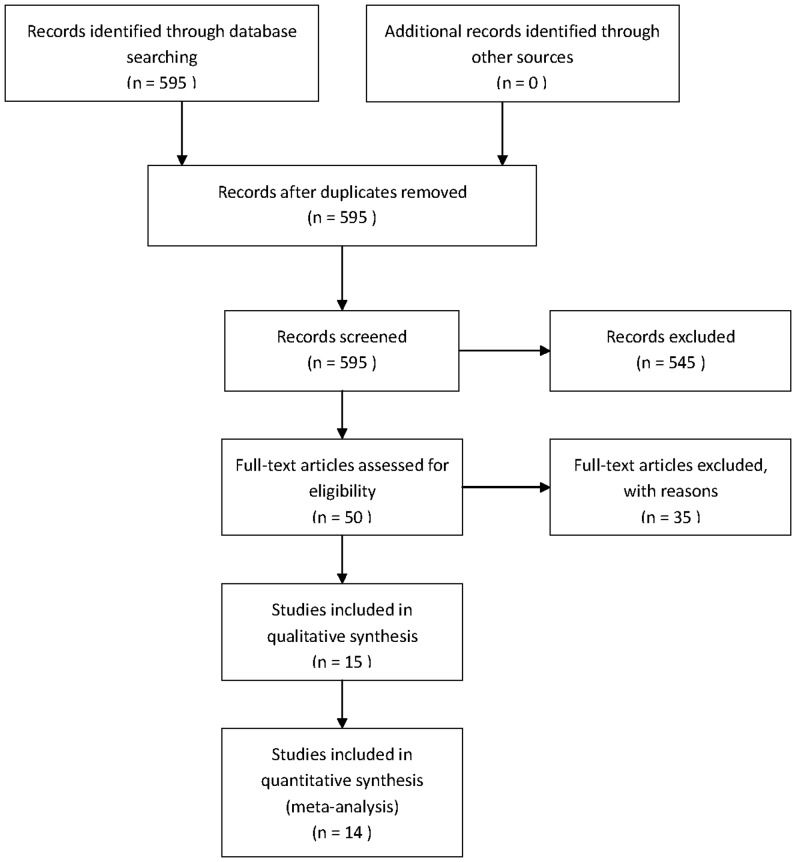
Flow diagram of study selection.